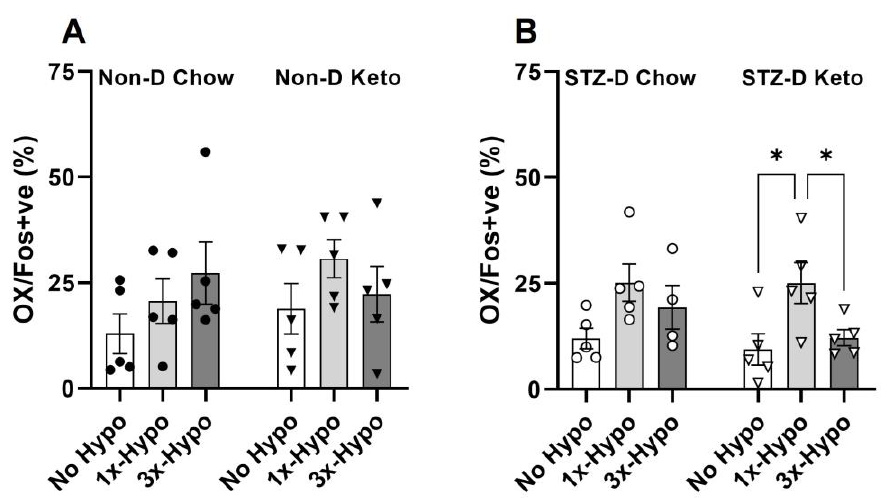
Figure 6. Recurrent hypoglycemia attenuates OX neurons activation in STZ-diabetic keto-fed rats. ( A ) The proportion of Fos-positive OX neurons did not change with hypoglycemic challenge in any of the non-diabetic groups of rats; ( B ) Single (1 × -Hypo) hypoglycemia increased the proportion of activated OX neurons in STZ-diabetic keto-fed rats compared to the No Hypo control and recurrent hypoglycemia (3 × Hypo) attenuated this increase; no differences in OX activity were detected in STZ-diabetic chow-fed rats. Data analysed by one way ANOVA with Holm–Šídák multiple comparisons test. Data are mean ± SEM, * p < 0.05.